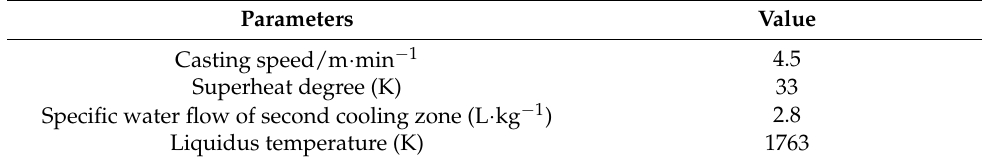
Table 2. The primitive process parameters in the present work.